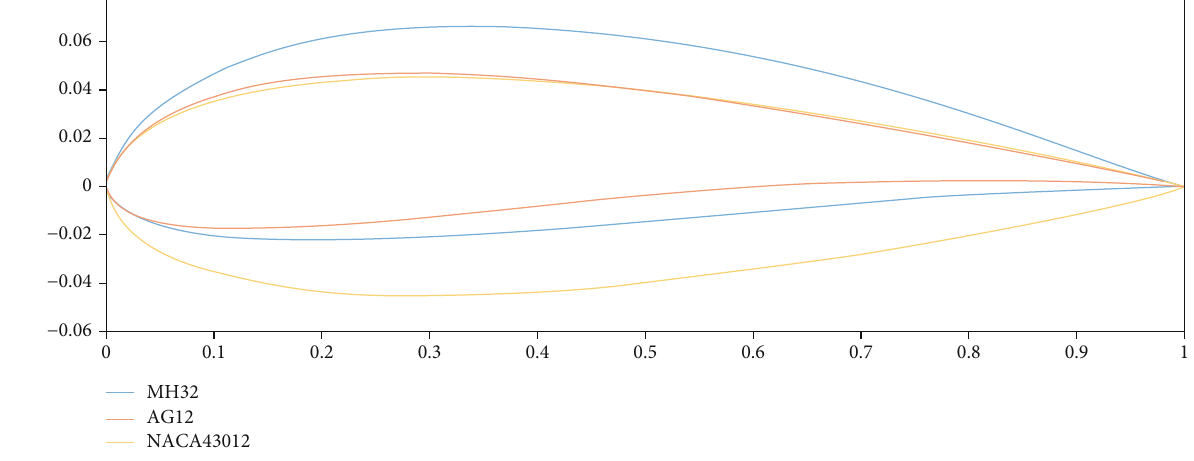
Figure 3: Aerodynamic airfoils selected for comparison.